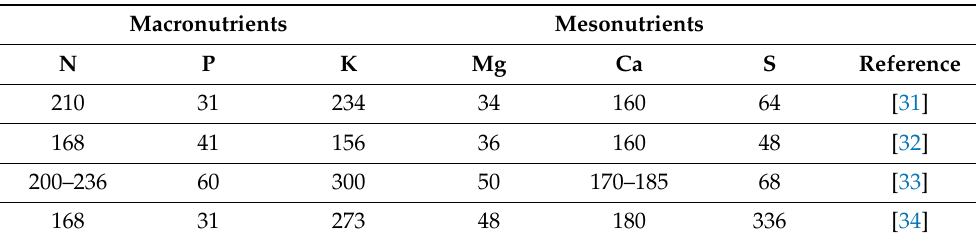
Table 2. Concentration of NPK (mg/L) in standard nutrient solutions for hydroponics, according to previous